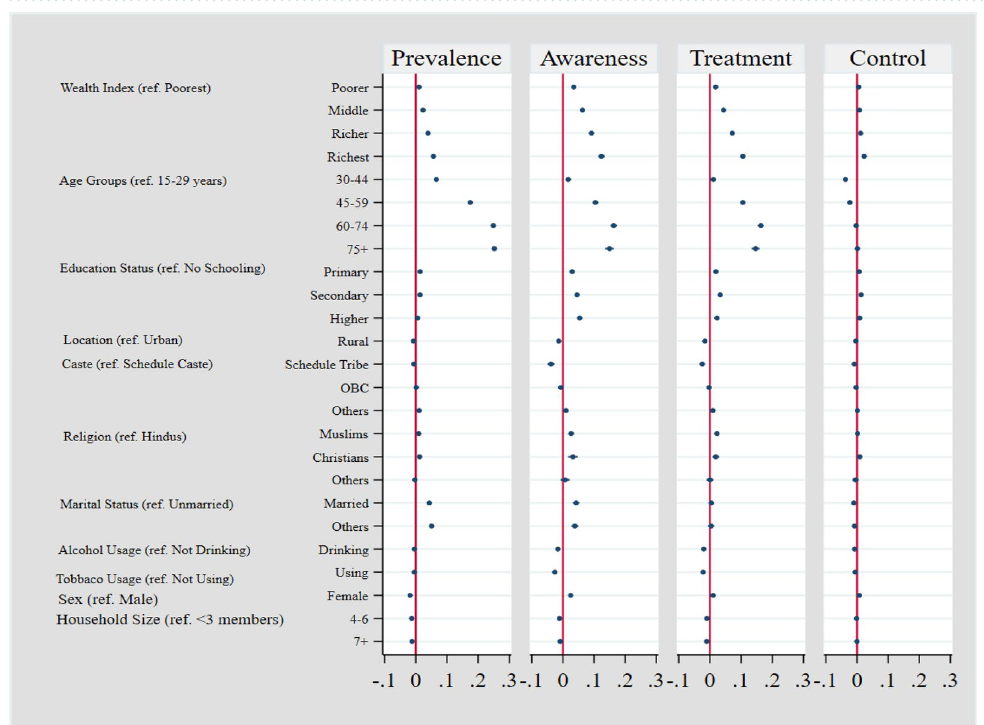
Figure 7. Averaged marginal effects on probability of diabetes and on probabilities of ATC among those with diabetes (see Supplementary Table